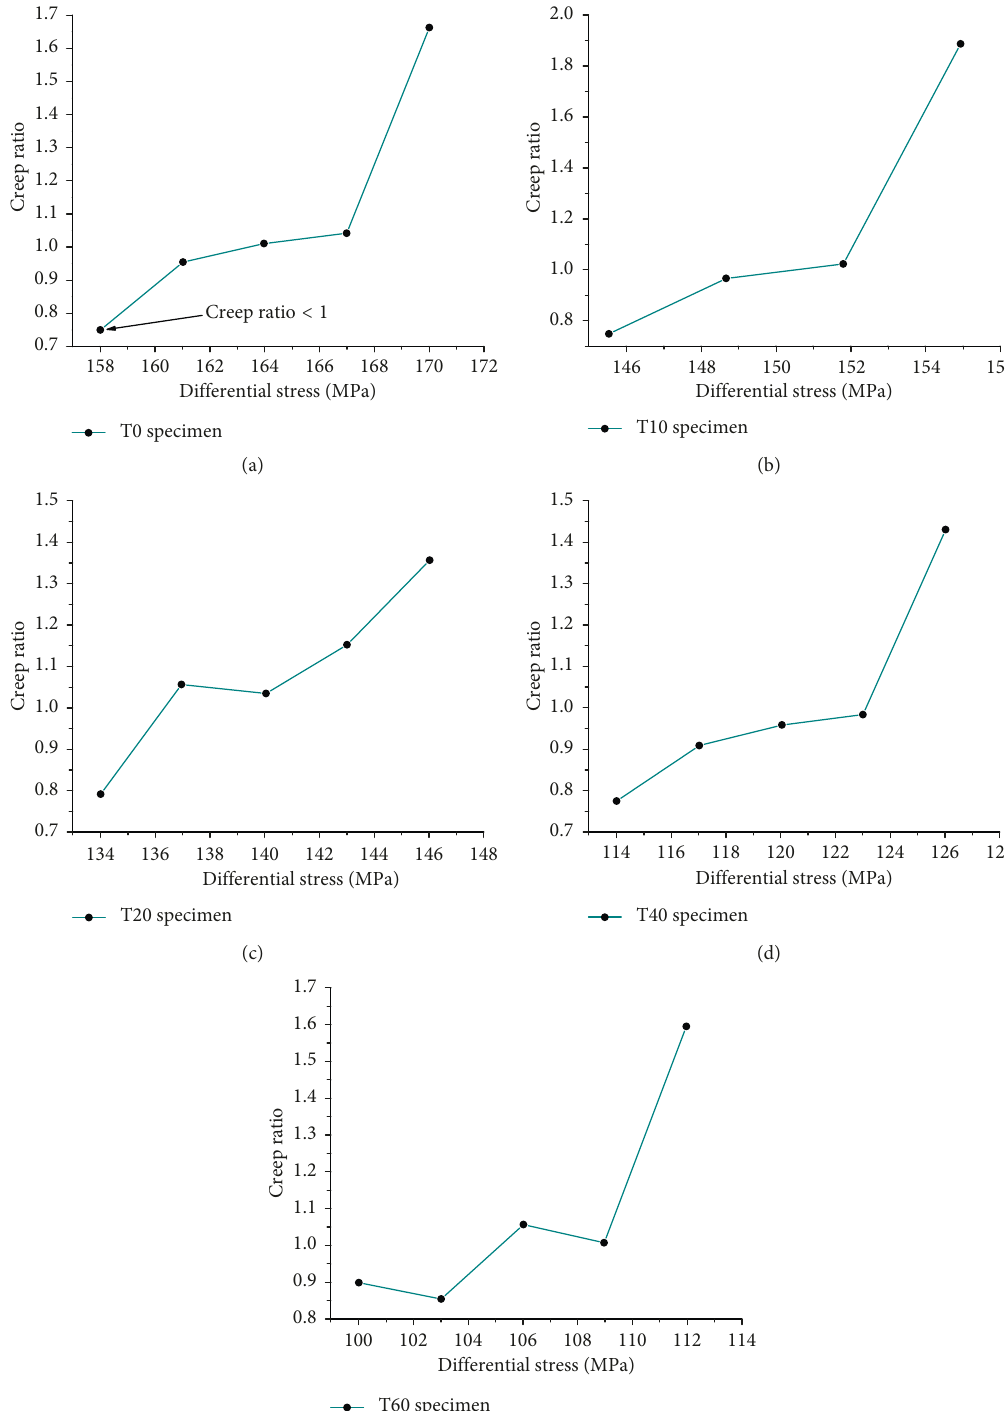
Figure 10: Variation of creep ratio ( Δ ε (c) T20 specimen. (d) T40 specimen. (e) T60